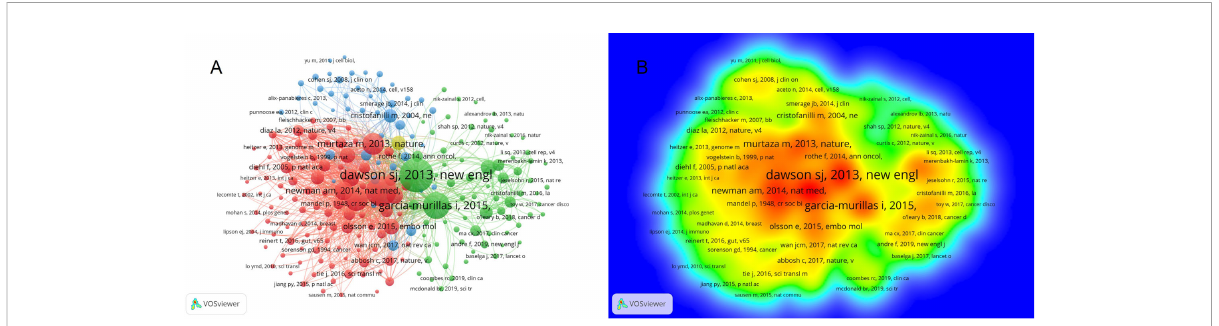
FIGURE 7 Co-citations analysis of cited references in this research fi elds. (A) The network visualization of co-citations analysis of cited references. (B) The density visualization of co-citations analysis of cited